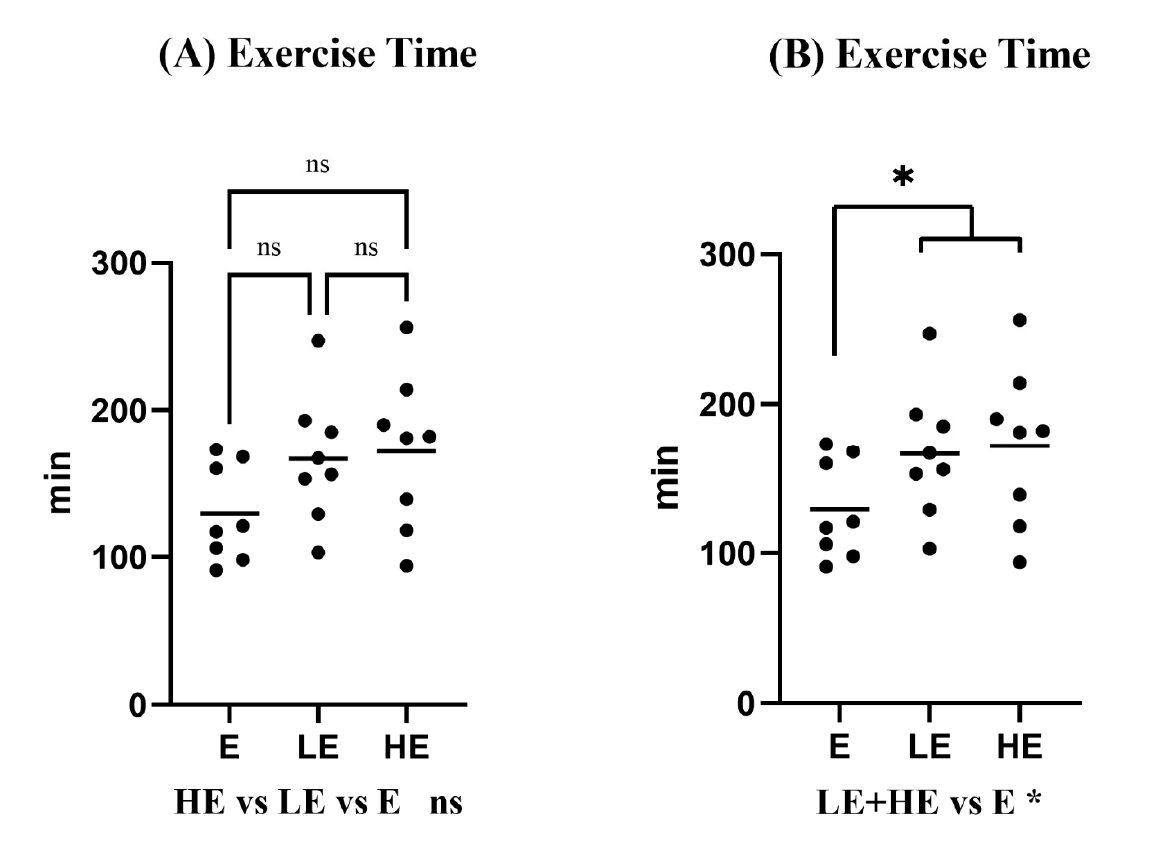
Figure 1. ( A ). The run time to exhaustion in between-group comparison. ( B ). The run time to exhaustion between the E group ( n = 8) and KPE administration groups (LE group ( n = 8) + HE group ( n = 8)). E group, γ -Cyclodextrin administration + exercise group; LE group, low-concentration KPE administration + exercise group; HE group, high-concentration KPE administration + exercise group. Values are means ± standard deviation (SD); ns, no significance observed; * p < 0.05, compared with the E group; dots: the specific time each mice ran to exhaustion.